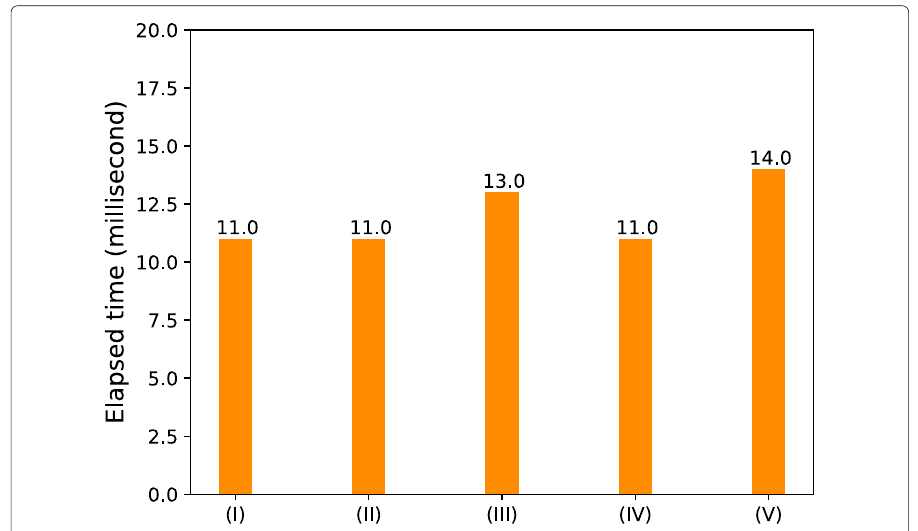
Fig. 17 Performance of HiResX running on different GPU topology. Cases in which all GPUs are in the same PCIe switch get best communication efficiency, see case I and II. For the case in which GPUs are located in different PCIe switches, if GPU devices are optimally assigned according to communication load, communication efficiency can also be improved, see case IV. Without GPU to GPU optimization, the communication efficiency is lower, see case III and